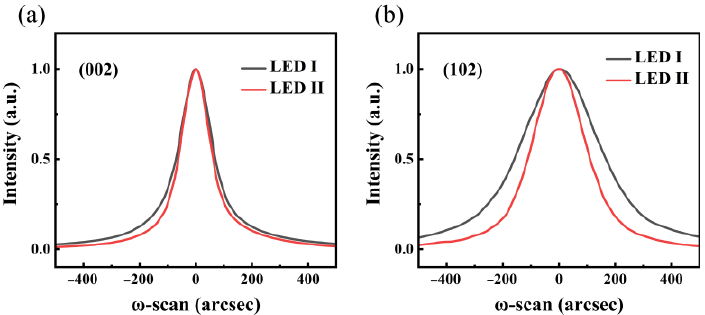
Figure 6. XRD rocking curves of ( a ) (002) and ( b ) (102) planes for LED I and LED II.